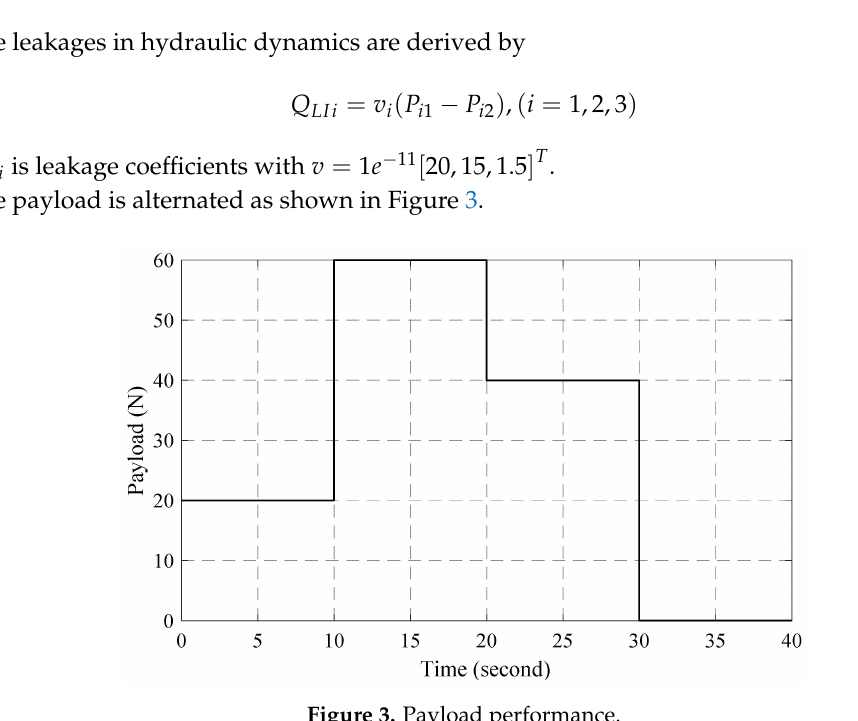
Figure 3. Payload performance.